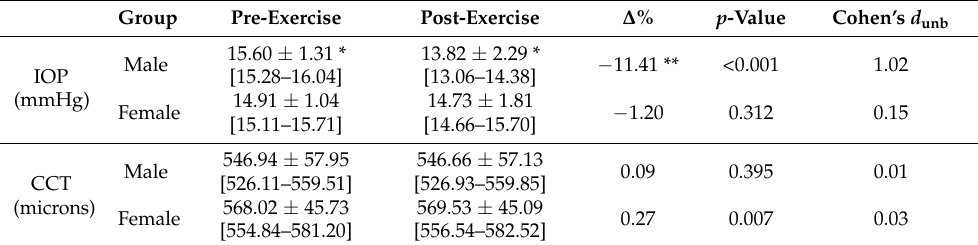
Table 3. Data comparison between the pre- and post-exercise intraocular pressure values, according to the sex of the participants (males, n = 18; females, n =